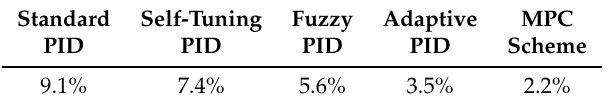
Table 6. Sensitivity analysis applied to the hydroelectric plant